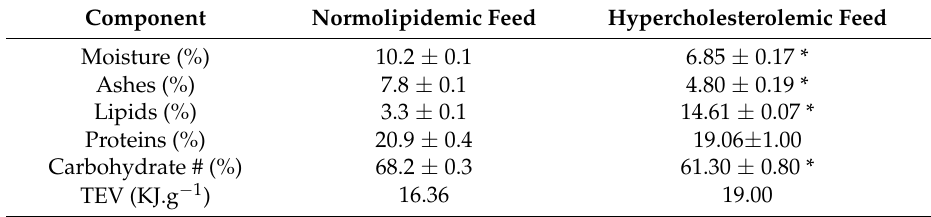
Table 1. Composition of the standard diet and hypercholesterolemic